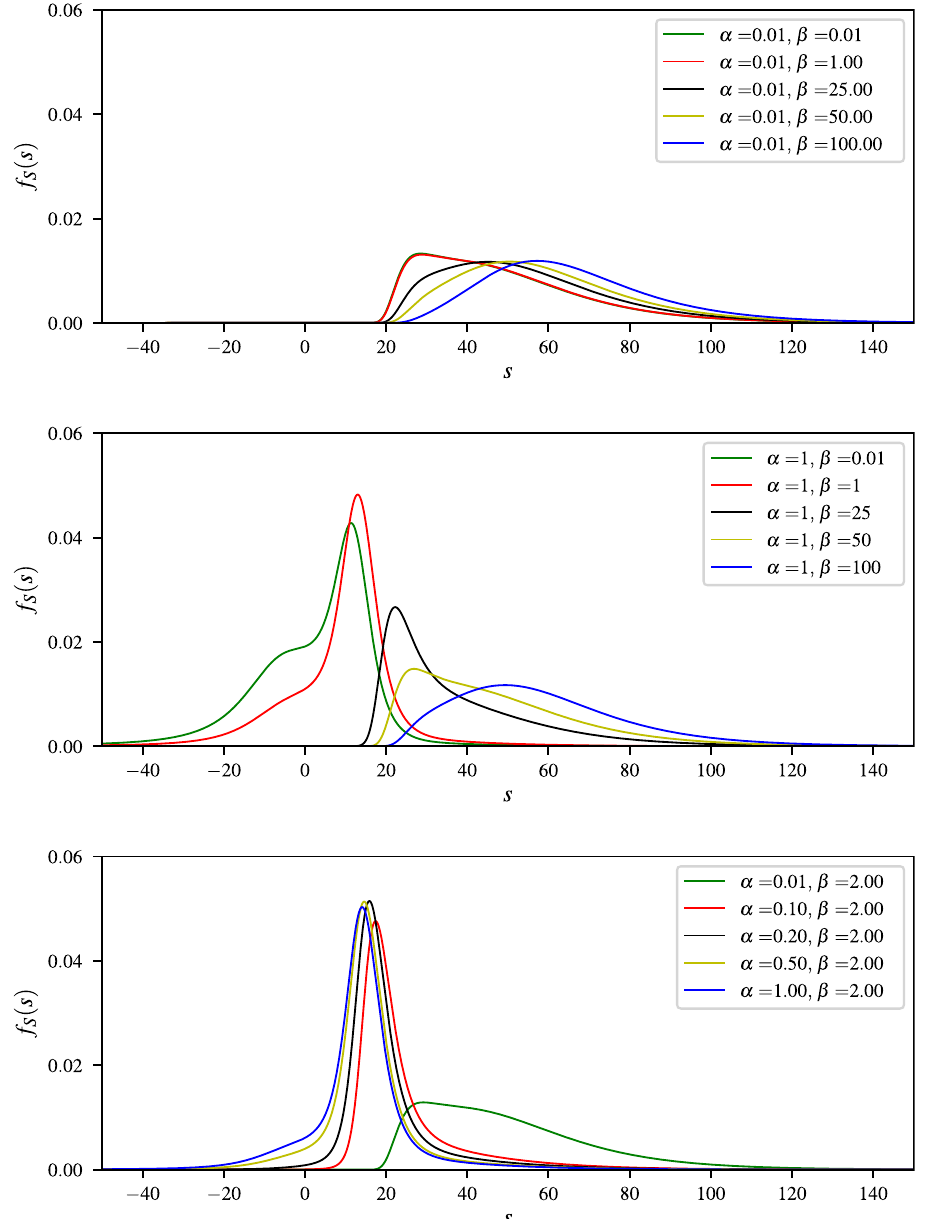
Figure 5. Plots of action potential distributions for some EEG signal with varying the parameters α and β